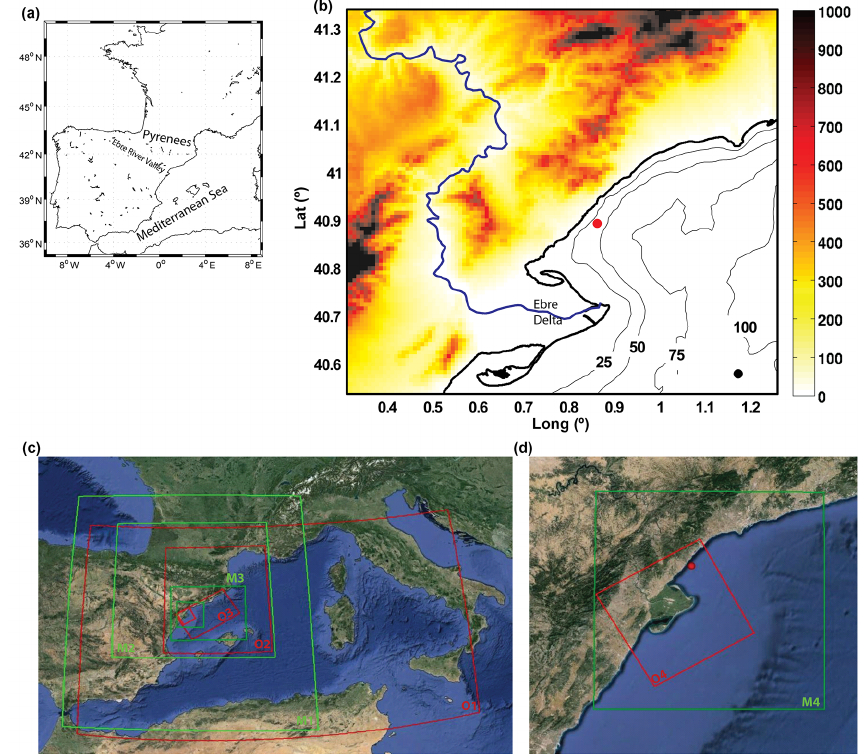
Figure 1. Localisation map (a) and orography (coloured map) and bathymetry of the study area (b) . The bathymetry lines are shown every 25m. The geographical position where the observational buoy was moored is shown with a red circle. The control point used in the analysis is shown with a black circle. (c, d) Geographical domains for the meteorological model (in green) and the wave and the water circulation model (in red). The mesh notation is also shown (its resolution is detailed in Table